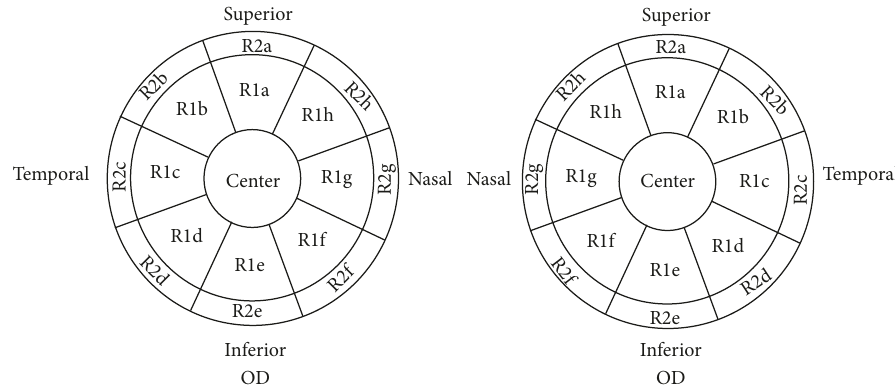
Figure 1: Details of the mapping of corneal thickness and corneal epithelial thickness over the 6mm diameter cornea from the analyzing report in the set. The analyzing area is divided into three main parts (center, Ring1, and Ring2) and 17 sectors. In Ring1, the sectors were named, respectively, anticlockwise for OD as R1a, R1b, R1c, R1d, R1e, R1f, R1g, and R1h. Similarly, the sectors from Ring2 for OD were named from R2a to R2h. The naming all started from superior to temporal, then inferior to nasal. The left eye map was mirrored. Table 1: Distinction of corneal epithelial thickness between the right and left eyes. Mean di ff erence ( μ m) SEM Sig. Right − left (R-L)